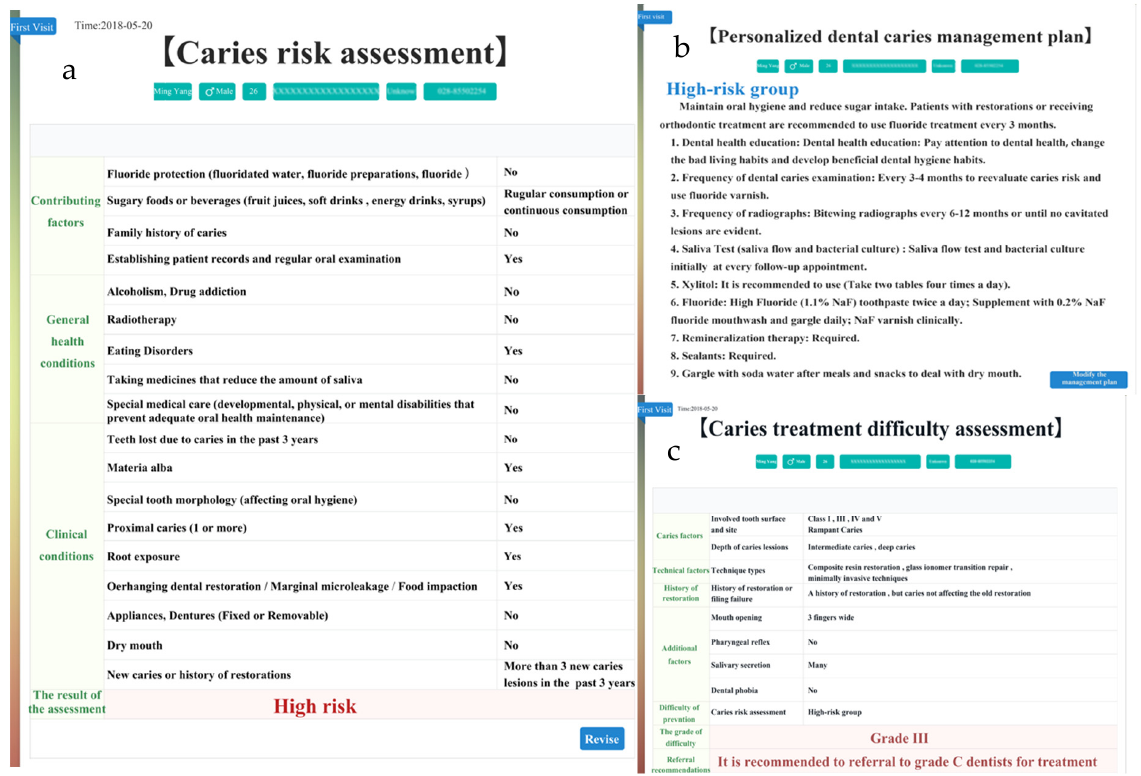
Figure 3. ( a ) Caries Risk Assessment Form; ( b ) Personalized caries management plan; ( c ) Caries treatment difficulty assessment.